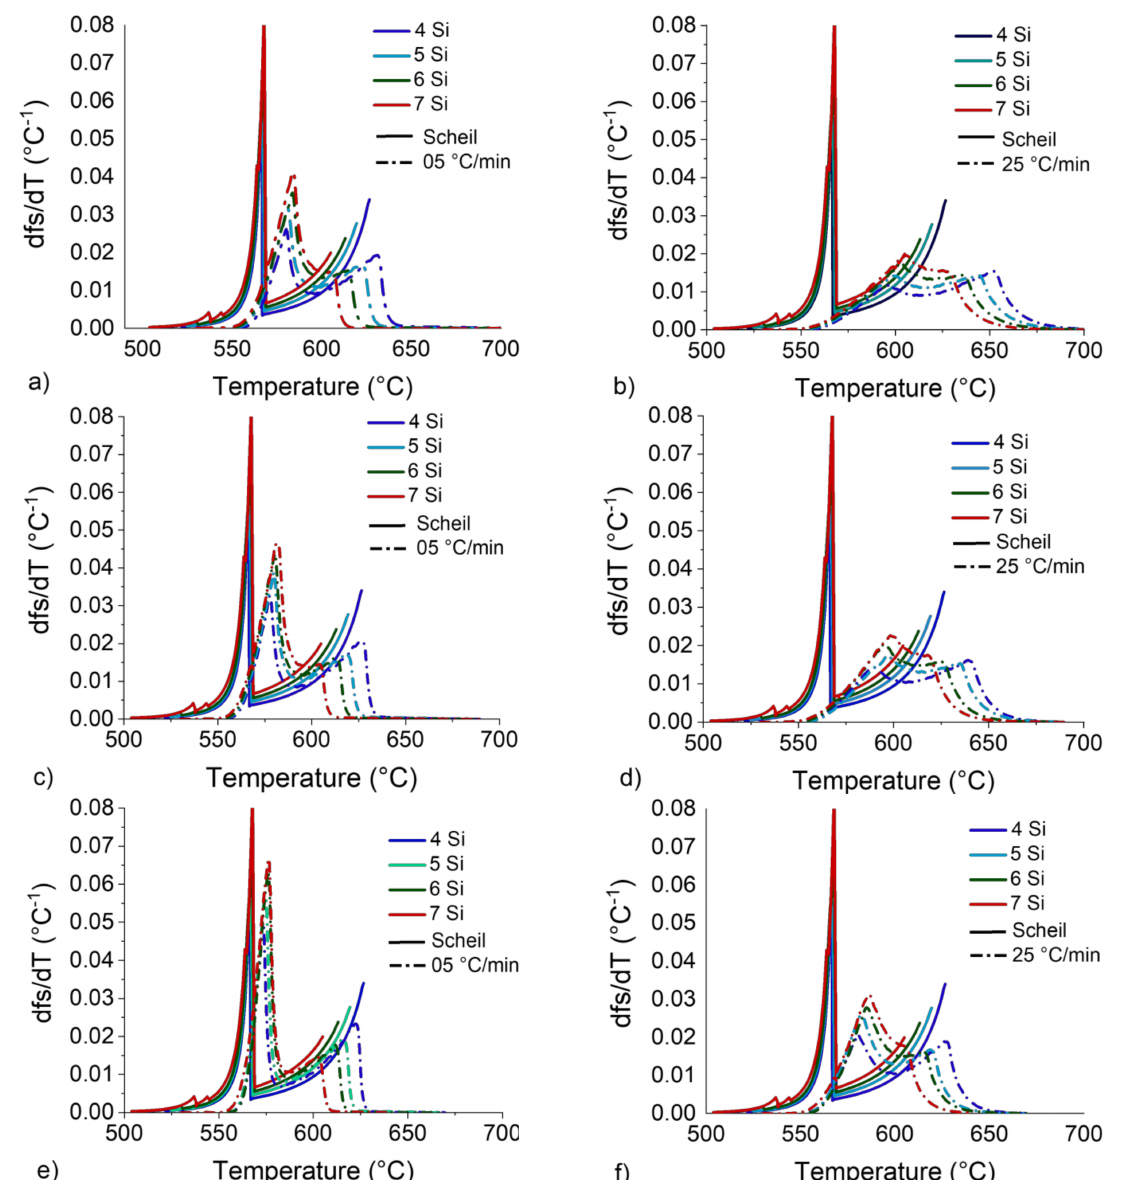
Figure 14. df S /dT vs. T curves for 4 to 7 wt.%Si obtained by CALPHAD simulation at the Scheil condition and DSC curves for heating rates of 5 (left) and 25 ◦ C/min (right) and DSC sample masses of 200 ( a , b ), 90 ( c , d ) and 20 mg ( e , f